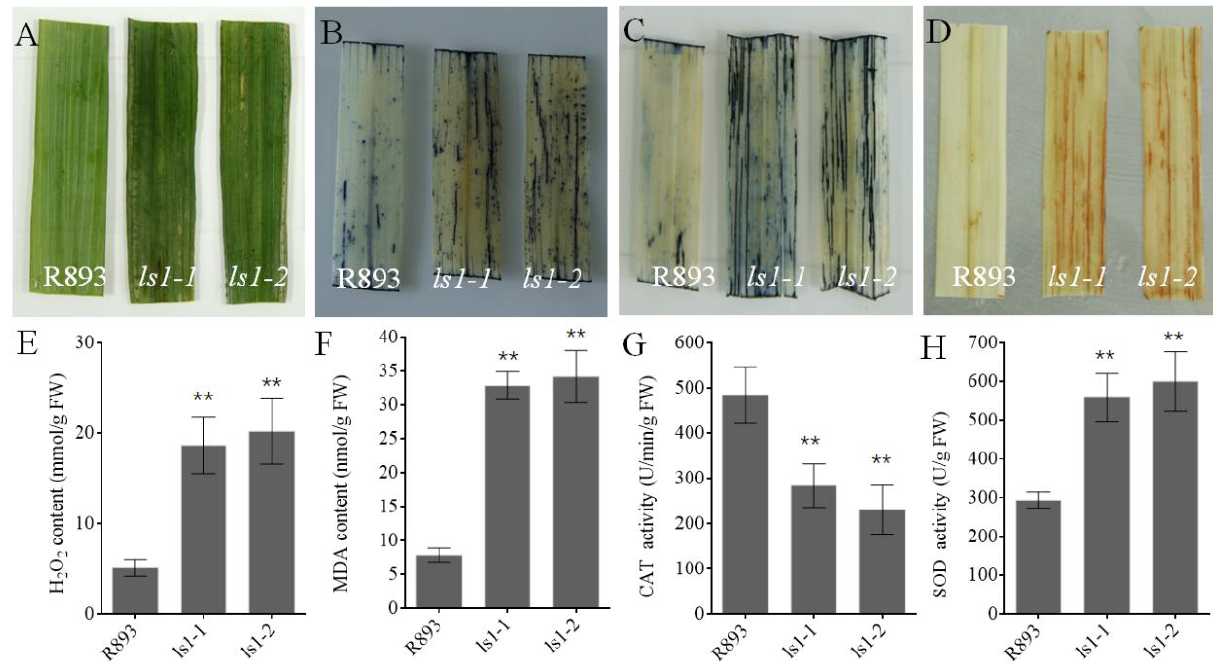
Figure 4. Analysis of ROS contents and measurement of physiological and biochemical parameters. ( A ) The leaves of WT, ls1-1 , and ls1-2 plants with no treatment at the heading stage. ( B – D ) NBT-, TB-, and DAB-stained leaves of WT and ls1 plants. ( E , F ) Measurement of the H 2 O 2 and MDA con- tents in WT and ls1 plants. ( G , H ) Activities of the ROS-related enzymes SOD and CAT in WT and ls1 plants. The error bars indicate SDs of three biological replicates. The p -value was calculated using a Student’s t -test. ** p < 0.01.